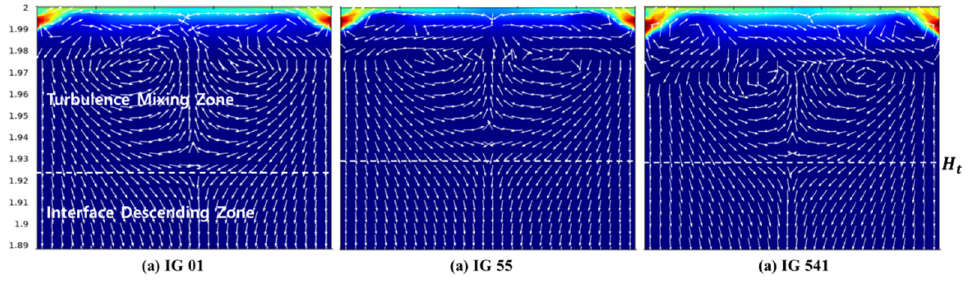
Figure 13. Schematic diagram of turbulence mixing zone and interface descending zone.